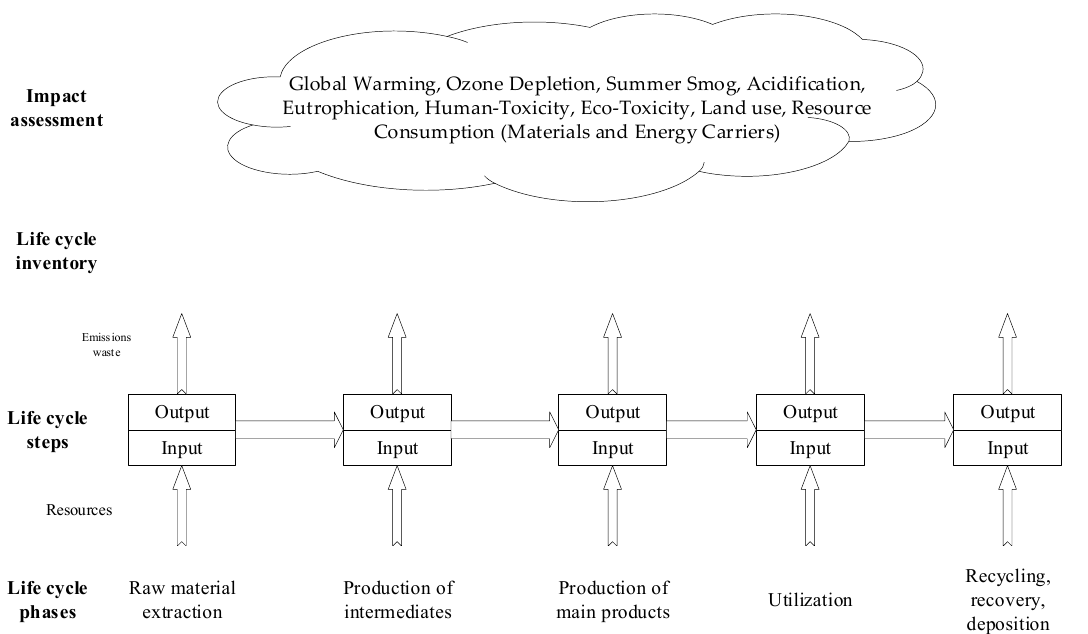
Figure 2. Overview of life cycle assessment in GaBi software [21].